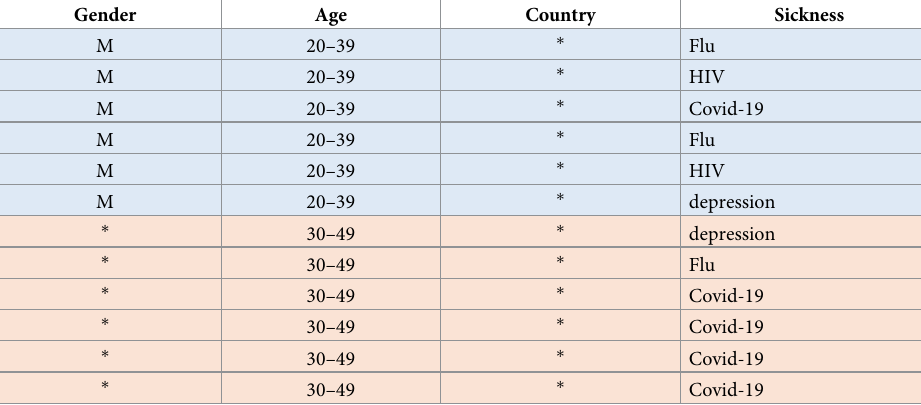
Table 3. Medical dataset in 3-diversity model.